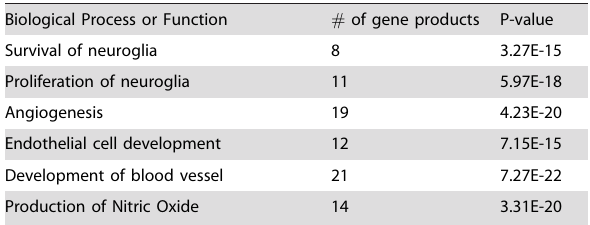
Table 1. The table displays biological processes or functions enhanced by Atorvastatin treatment identified by Ingenuity Pathway Analysis as significantly (p , 0.05) associated with the